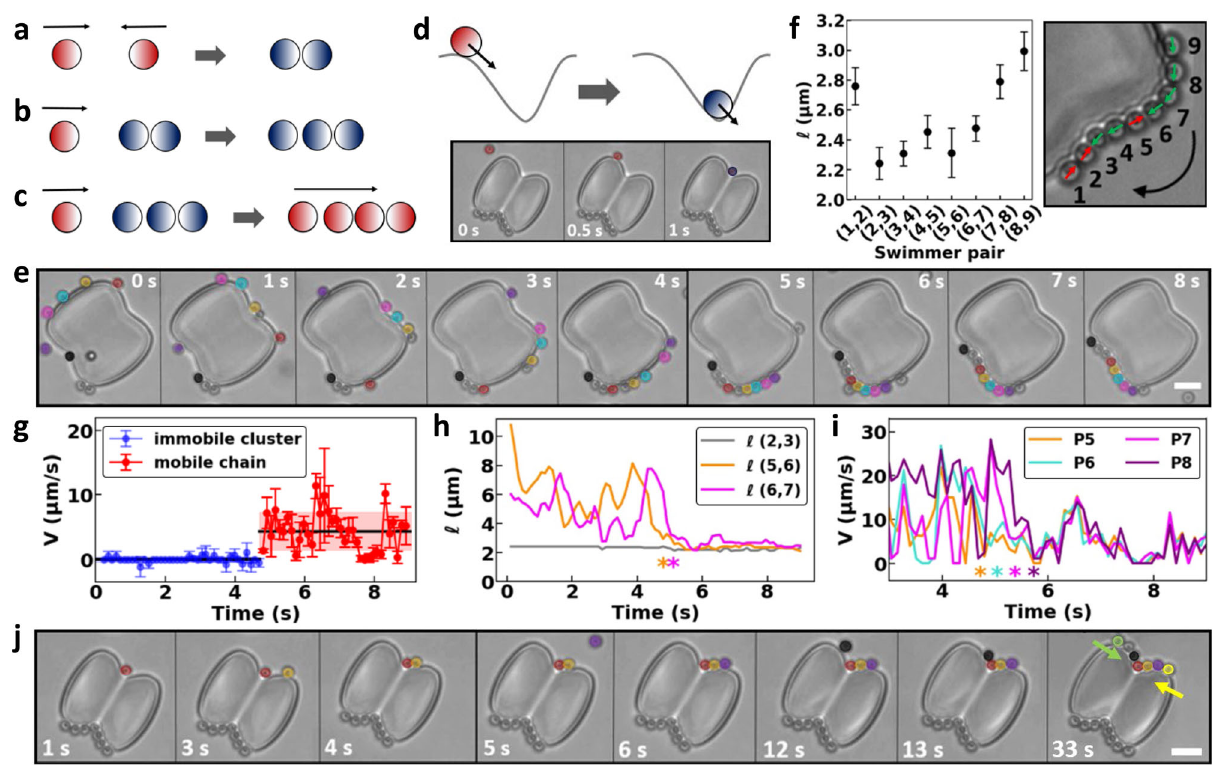
Fig. 4 Activity-assembled chains of microswimmers on peanut-shaped posts. a – d Schematic representations of the conditions determining chain mobility. Red and blue colors indicate mobile and immobilized swimmers, respectively. The darker hemispheres represent the Pt side, which drives motion. a Two swimmers with opposing motion direction become immobile. b When a third swimmer approaches the cluster, it gets in contact and also becomes stationary. c A fourth swimmer, entering from the same side as in b , causes the chain to move again in the direction of the majority of swimmers. d In highly curved neck regions, swimmers stop temporarily because a reorientation is required, see also the light microscopy image at the bottom. e Dynamic chain formation, see also Supplementary Movie 5: initially, self-propelled swimmers headed by the red swimmer move clockwise in a train. After being stopped by an immobile cluster at the lower left edge, the train becomes a compact chain that moves after further addition of swimmers. f Center-to-center distance between swimmer pairs varies within a mobile chain. Front of the chain is swimmer 1. Particle numbering, direction of motion of the entire chain (curved arrow), and direction of motion of the individual particles (straight arrows, red is for counterclockwise and green for clockwise direction) are indicated in the bright fi eld image on the right. g Speed of the chain at the bottom-left post corner in panel ( e ) as a function of time. While initially being immobile, the chain remobilizes upon addition of swimmers at t = 5s. h , i Particle labeling follows panel ( f ). Asterisks indicate the time at which the individual swimmer (in h ) or the front swimmer of the pair (in i ) met the chain. h Distances of swimmer pairs that orbit the peanut-shaped posts shown in panel ( e ). The train of particles compacts into a chain upon collision with the immobile cluster on the bottom-left corner; once swimmers are part of the chain, their relative distance remains roughly constant even when the chain gets remobilized. i Speed of individual swimmers from panel ( e ) in time. Speeds of swimmers in a train fl uctuate, whereas all swimmers move at the same speed in a chain. j Posts with a more negative neck curvature enhance the formation and pinning of compact and immobile chains, see also Supplementary Movie 6. This time series is a continuation of the one in panel ( d